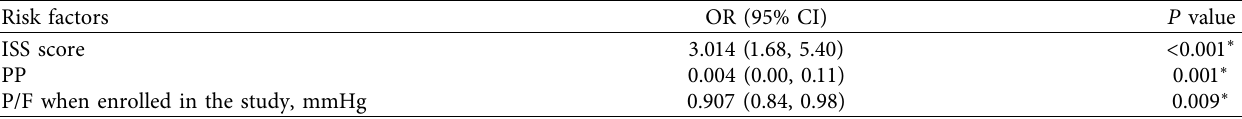
Table 3: Independent risk factors associated with death in hospital identified by multivariate logistic regression analysis.